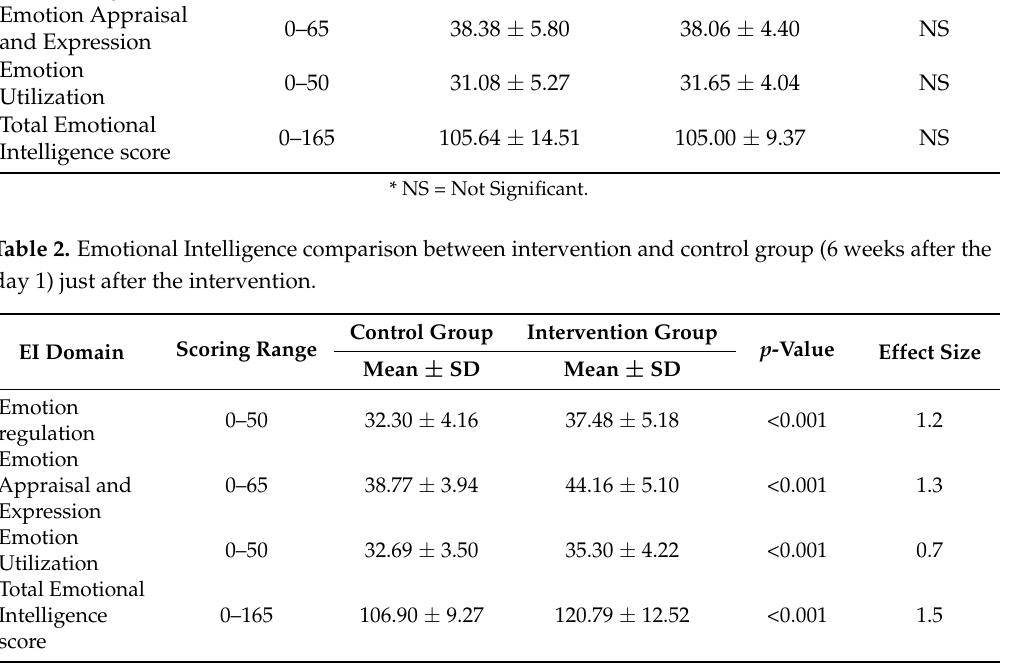
Table 3. Emotional Intelligence comparison between intervention and control group, in follow up Measurement (8 weeks after the end of